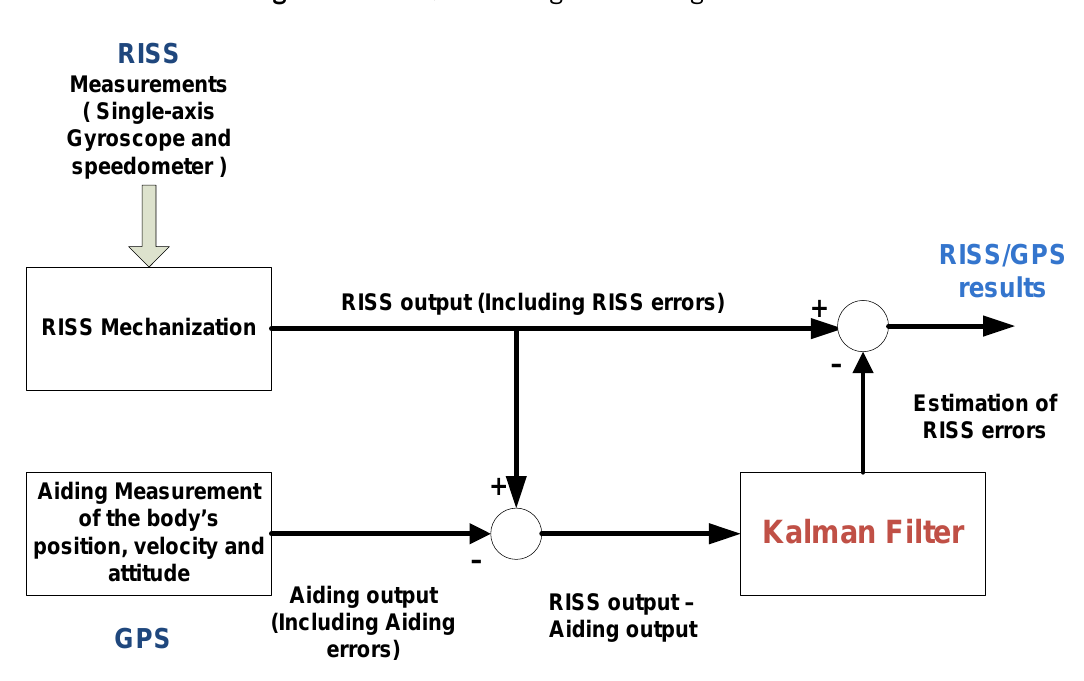
Figure 2. RISS/GPS Integrated Navigation